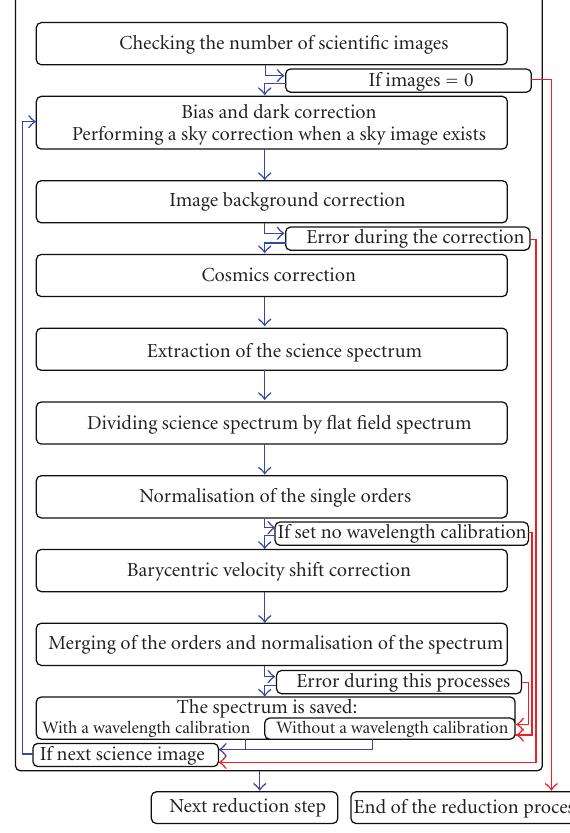
Figure 6: Flow chart with the main steps of the spectrum extraction form the single science